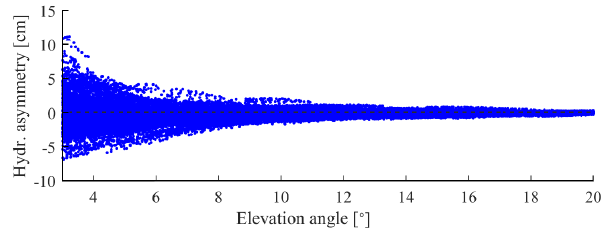
Figure 1. Hydrostatic component of azimuthal asymmetry, derived from the ALADIN-CZ model data by